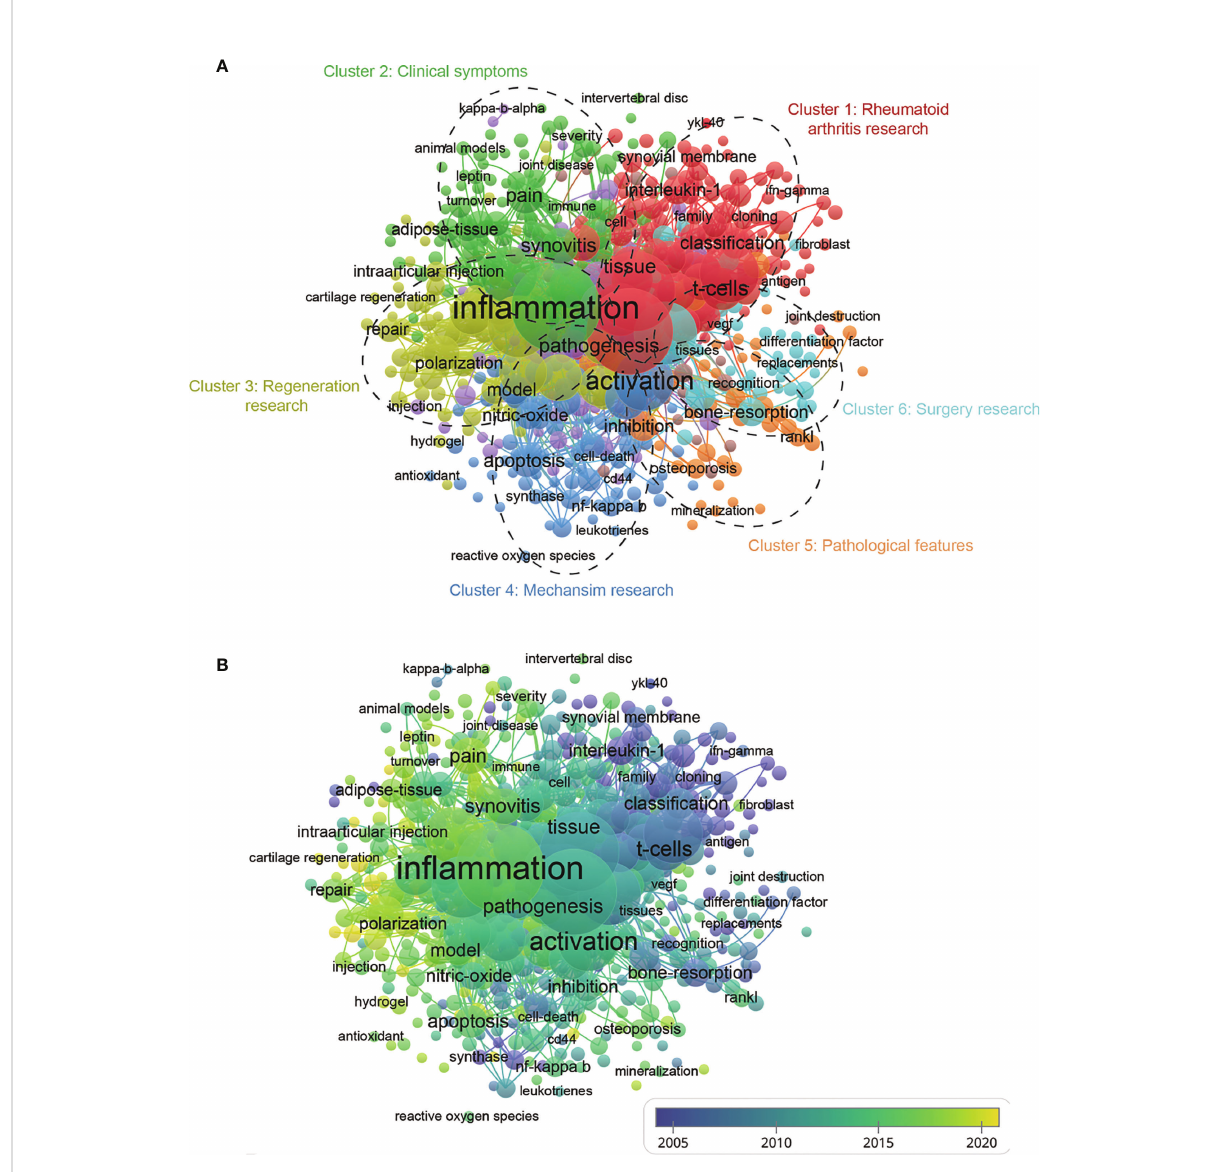
FIGURE 8 (A) Mapping of keywords in the research related to macrophages associated with osteoarthritis; the frequency is represented by point size and the keywords of research fi elds are divided into six clusters: rheumatoid arthritis research (red), clinical symptoms (green), regeneration research (yellow), mechanism (dark blue), pathological features (dark brown), and surgery research (baby blue). (B) Distribution of keywords according to the mean frequency of appearance; keywords in yellow appeared later than those in